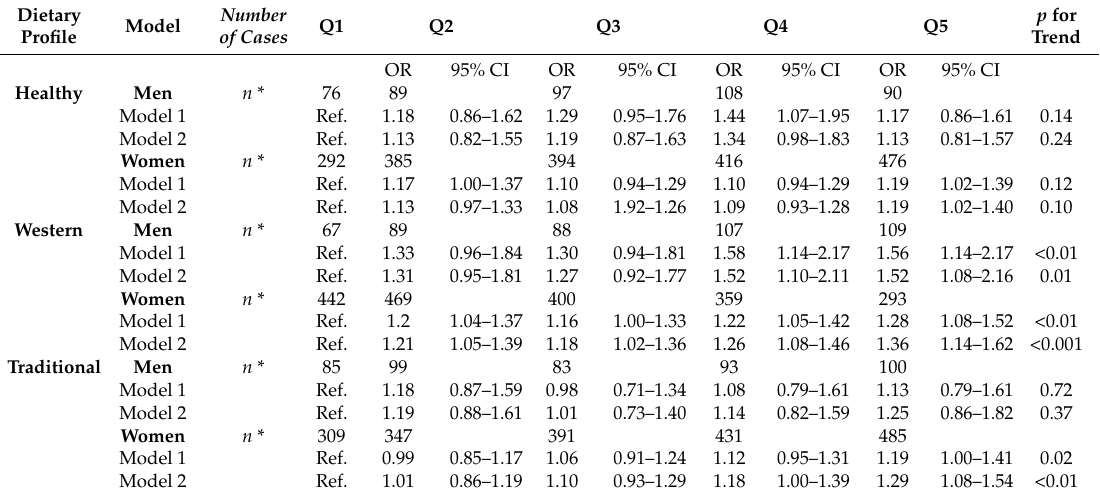
Table 4. Adjusted associations between dietary profiles and Irritable bowel syndrome ( n = 44,350). Dietary